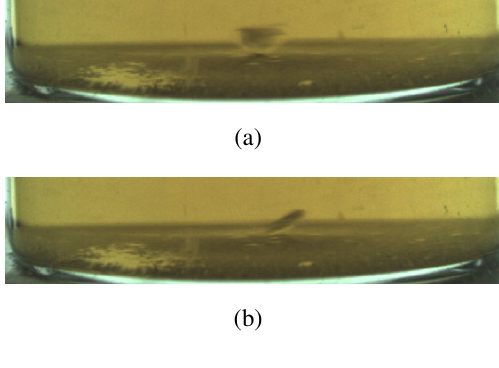
Figure 4. Two contiguous frames with glass. (a) Glass in frame i , (b) Glass in frame ( i + 1)